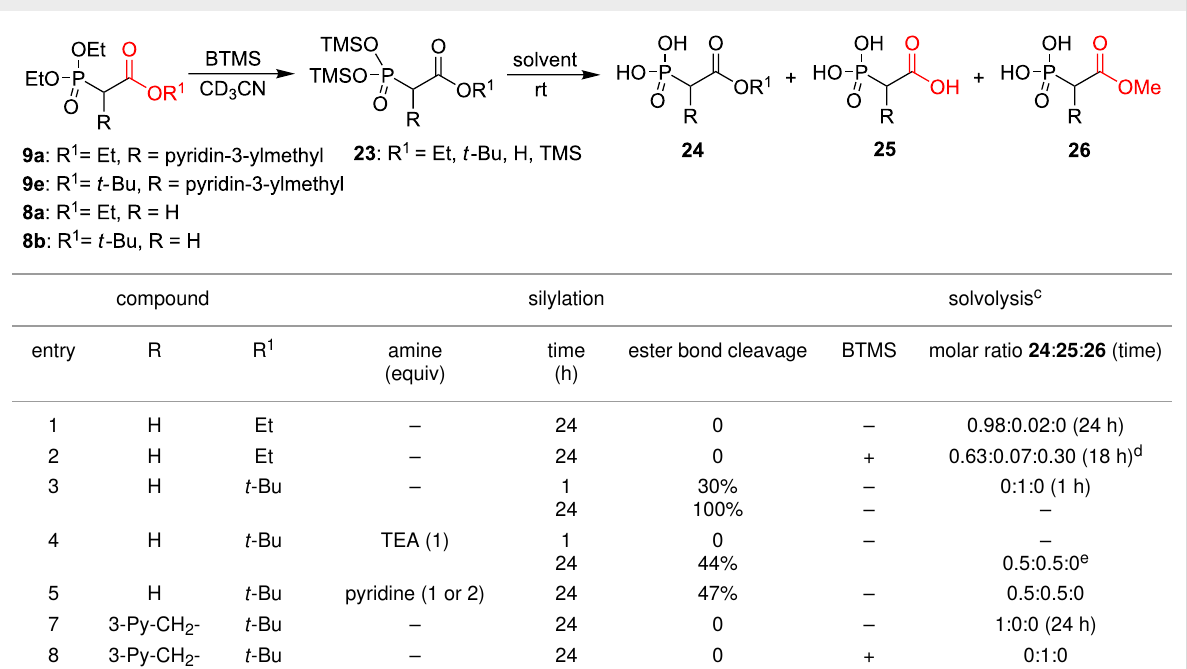
Table 4: The stability of compounds 8 / 9 during the McKenna reaction. a,b